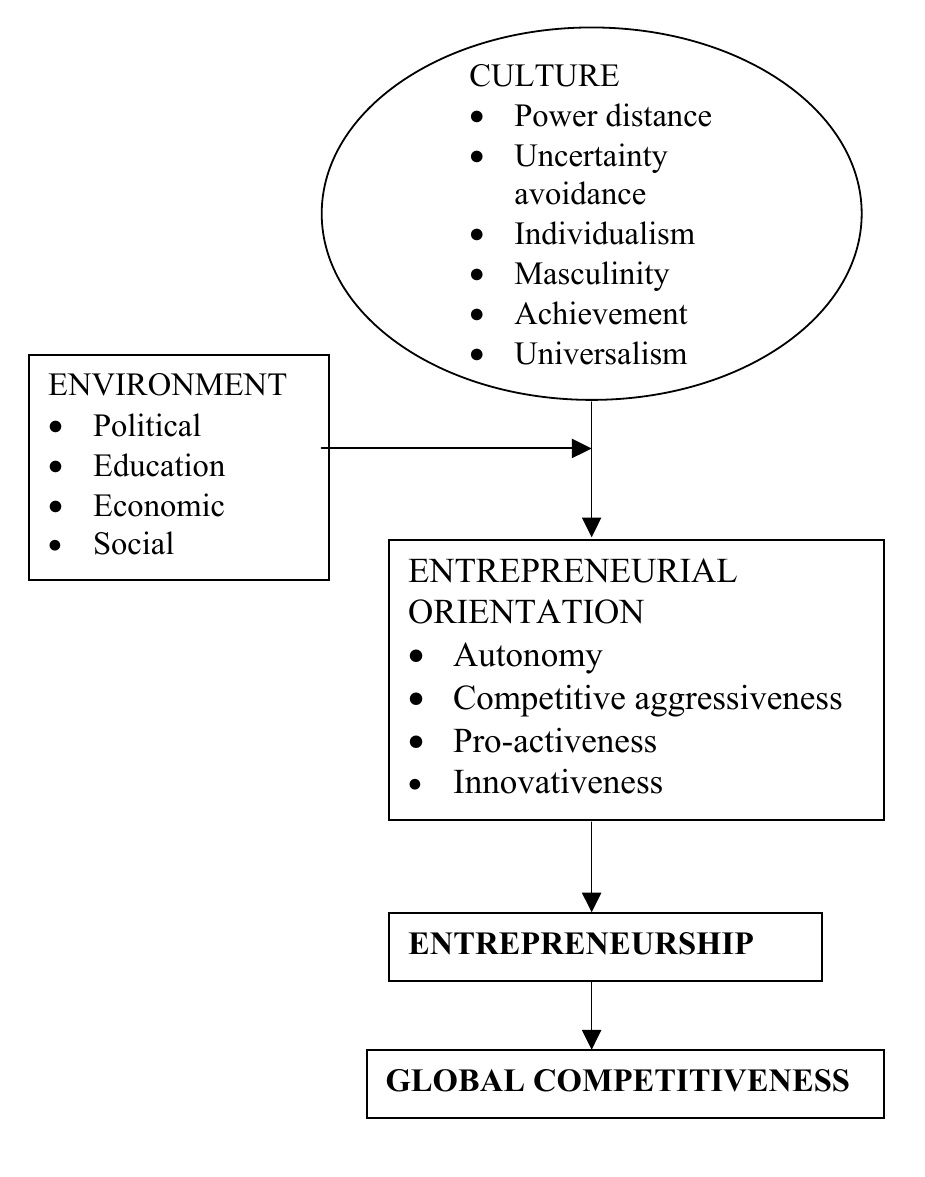
Figure 1 Model depicting the relationship between culture